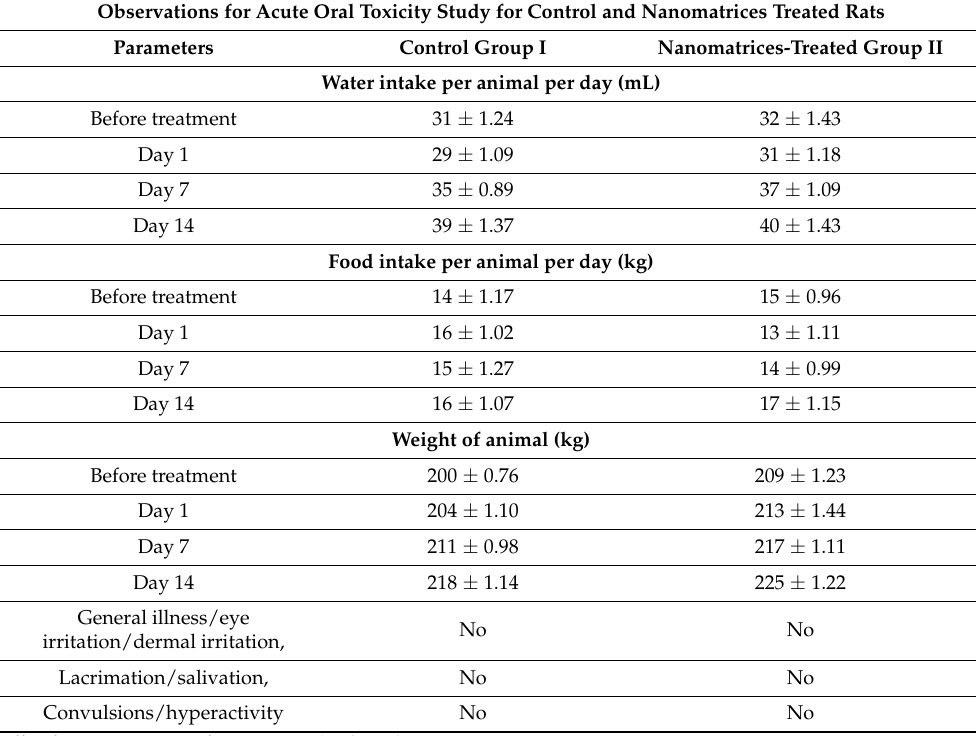
Table 3. Clinical remarks on the acute toxicity study for orally administered nanomatrices. Observations for Acute Oral Toxicity Study for Control and Nanomatrices Treated Rats Parameters